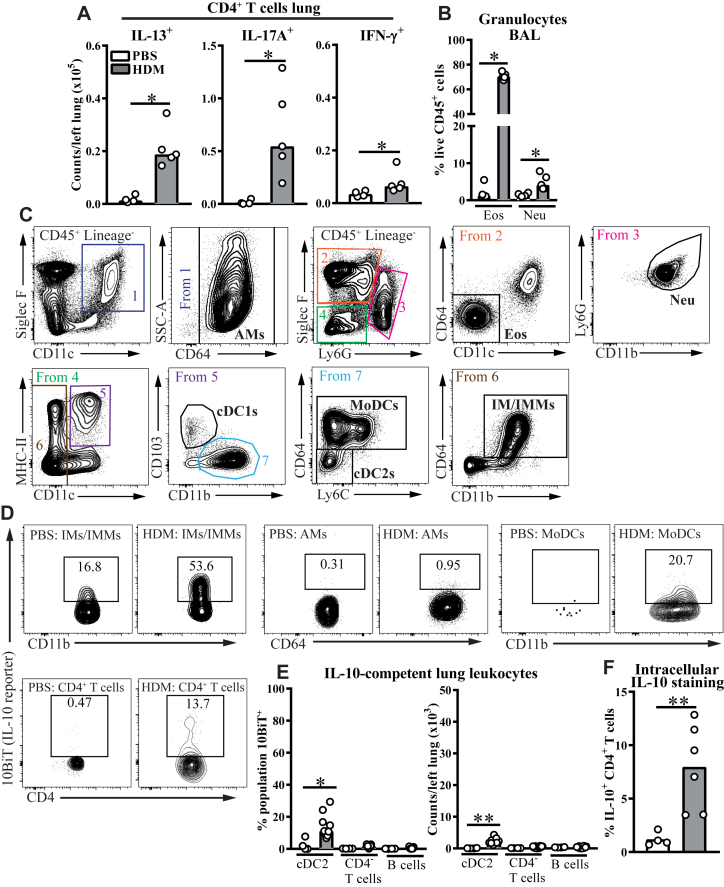
Cellular phenotype and IL-10 production in HDM inhalation mouse asthma model. Flow cytometric data are shown. A, Numbers of CD4+ T cells with the indicated cytokine expression phenotype in lung tissue of C57BL/6 mice. B, Siglec-F–high CD64− eosinophils (Eos) and Ly6G-high CD11b-high neutrophils (Neu) as percentages of total CD45+ leukocytes in BAL fluid of C57BL/6 mice. C, Hierarchical strategy for gating mouse myeloid cells beginning with live, singlet, CD45+, lymphocyte lineage (CD90.2, CD19, NKp46)–negative cells. Representative plots from lungs of HDM-treated C57BL/6 mice are shown. D, Representative plots showing 10BiT reporter expression in the indicated populations. E, Quantification of percentages and absolute numbers of the indicated cell populations expressing the 10BiT reporter. F, Percentage of lung CD4+ T cells from C57BL/6 mice with intracellular IL-10 staining after PMA and ionomycin stimulation. Data shown are medians of displayed values. Data in Fig E1, A, B, and F, are from 1 of 2 experiments (n = 3-6 per group) showing comparable results. Data in Fig E1, E, are pooled from 2 experiments (n = 4-9 per group). *P < .05 and **P < .01.